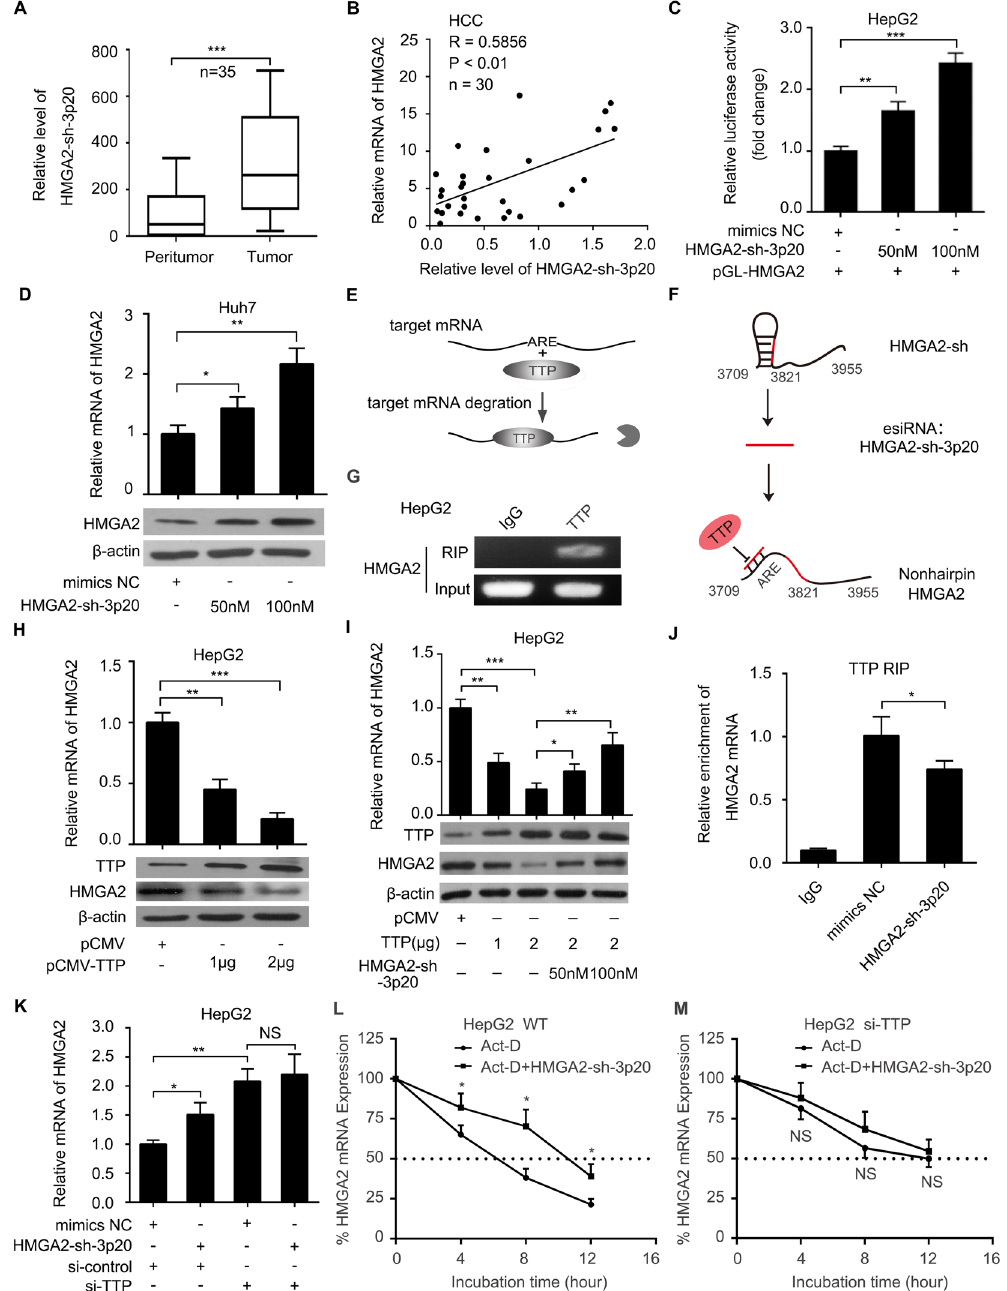
Figure 3. HMGA2-sh-3p20 upregulates HMGA2 by blocking the TTP-mediated degradation of HMGA2 mRNA. ( A ) The relative expression of HMGA2-sh-3p20 was assessed by qRT-PCR in 35 pairs of clinical HCC tissues and corresponding peritumor tissues ( *** P < 0.001; Wilcoxon’s signed-rank test). ( B ) The correlation between HMGA2 mRNA levels and HMGA2-sh-3p20 levels was measured by qRT-PCR in 30 cases of clinical HCC tissues ( ** P < 0.01, r = 0.586; Pearson’s correlation coefficient). ( C ) The luciferase activities of pGL3-HMGA2 were examined by luciferase reporter gene assays in HepG2 cells. ( D ) The expression of HMGA2 was assessed by qRT-PCR and Western blot analysis in Huh7 cells. ( E ) The diagram of TTP-mediated mRNA degradation. ( F ) The diagram of HMGA2-sh-3p20 antagonizes the interaction of TTP with non-hairpin within 3 ′ UTR of HMGA2 mRNA. ( G ) TTP RIP-PCR of HMGA2 in HepG2 cells. ( H ) Effect of TTP on the expression of HMGA2 was measured by qRT-PCR and Western blot analysis in HepG2 cells. ( I ) Effect of HMGA2-sh-3p20 on the expression of TTP-mediated HMGA2 was assessed by qRT-PCR and Western blot analysis in HepG2 cells. The full length blots images are given as Supplementary Fig. S7. ( J ) TTP RIP-qPCR of HMGA2 in HepG2 cells transfected with HMGA2-sh-3p20. ( K ) Effect of HMGA2-sh-3p20 on the levels of HMGA2 mRNA in HepG2 cells transfected with si-TTP by qRT-PCR. ( L , M ) Effect of HMGA2-sh-3p20 on the half-life of HMGA2 mRNA in HepG2 cells ( L ) or HepG2 cells transfected with si-TTP ( M ) by qRT-PCR. Every experiment was repeated three times. Error bars represent s.d. (n = 3), ** p < 0.01; *** p < 0.001 and not significant (NS), Student’s t